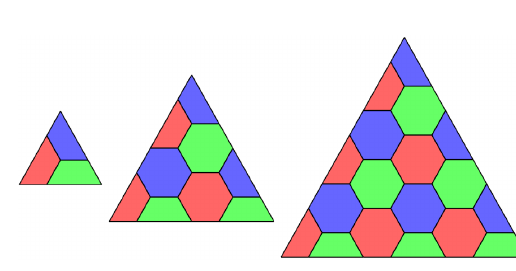
FIG. 5. 2D color codes of distances 3, 5, and 7.